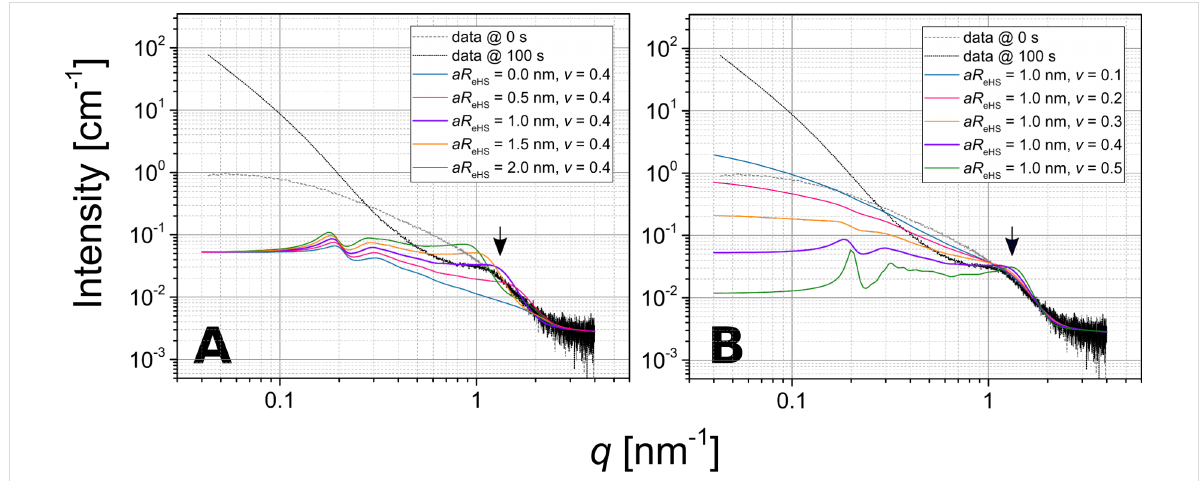
Figure 2: Comparison of the measured (black) and simulated (coloured) scattering patterns to illustrate the contribution of S SHS ( q ) from Equations 5–14, plugged into Equation 2 as the only structure-factor expression. It was the aim to represent the correlation peak at q ≈ 1 nm − 1 , whereas the effects at low q are further discussed in the text and in Figure 3. A) The position of the correlation peak at q ≈ 1 nm − 1 (arrow) is reproduced more accurately by S SHS ( q ) for the polydisperse silica NPs (Figure 1B), only if one considers an additional effective hard sphere radius, aR eHS (Equation 16); B) the effect of the local volume fraction ν onto the intensity of the correlation peak (arrow). The data uncertainties are not shown for